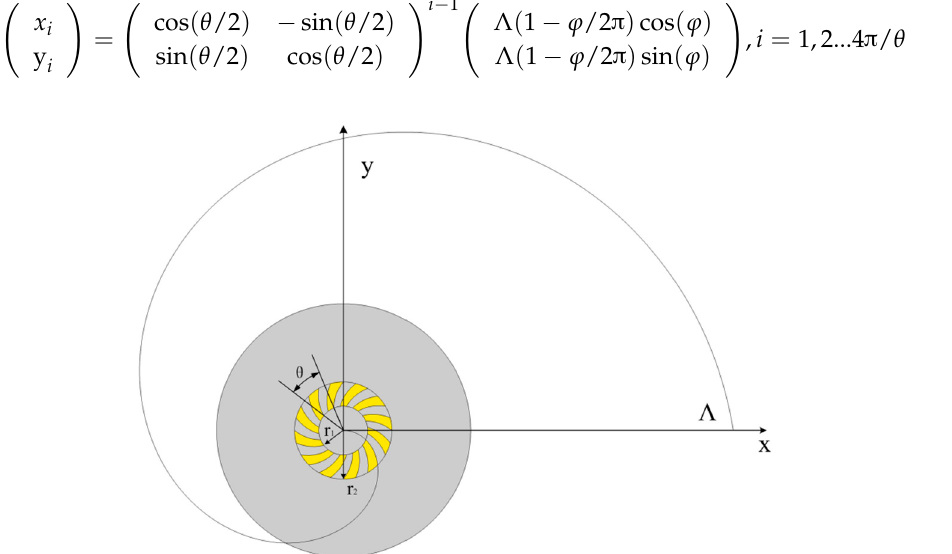
Figure 14. Schematic diagram of the metallic spiral-ring structure. Circularly-polarized illumination